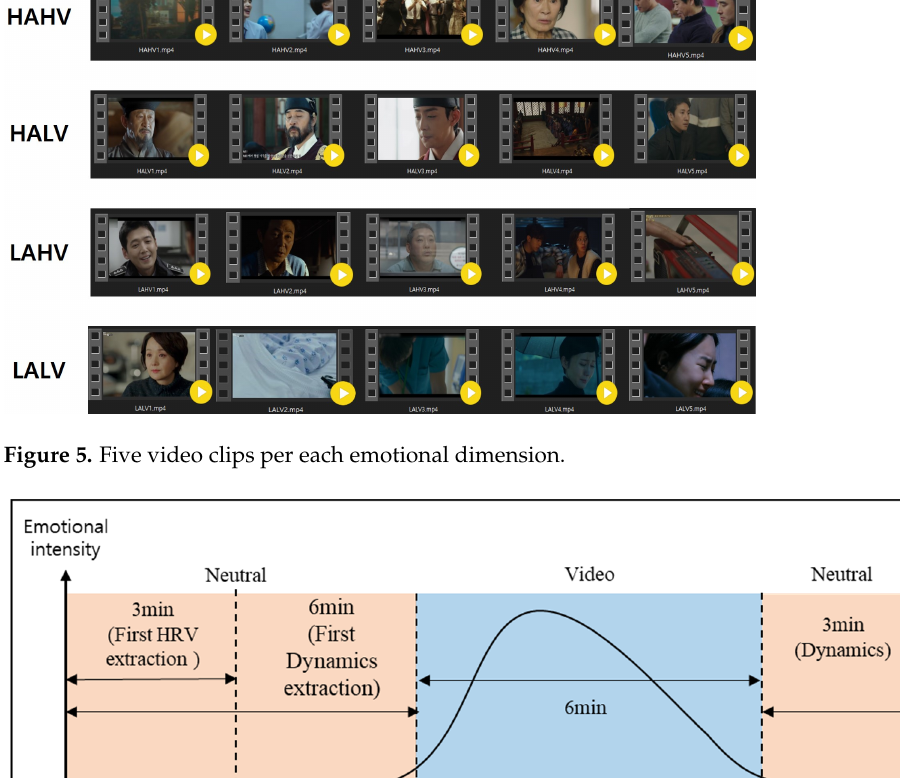
Figure 5. Five video clips per each emotional dimension .